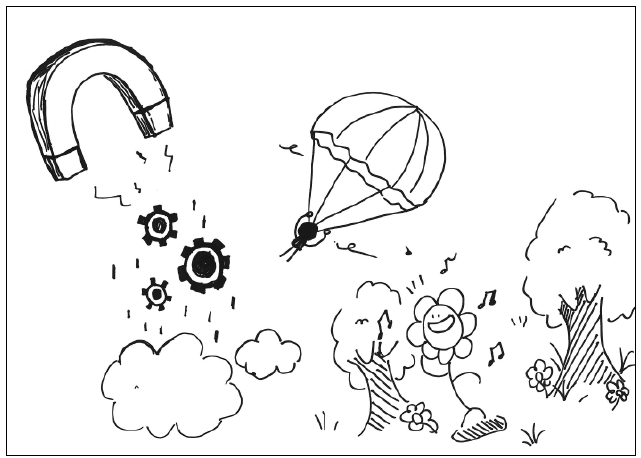
Figure 2. Work by PT2 Agreeableness.